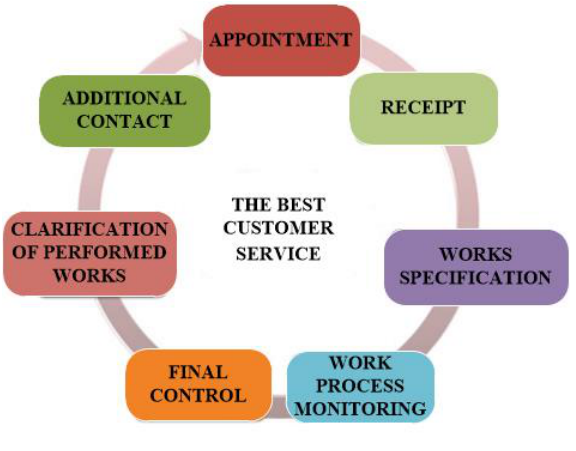
Figure 1. Seven steps of the after-sales process